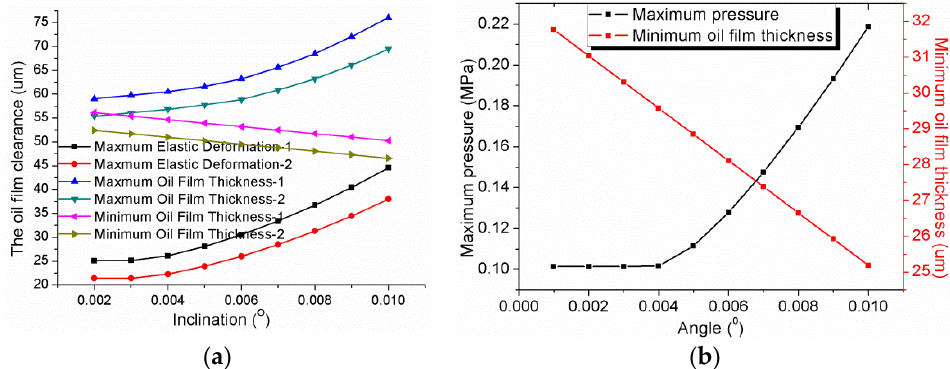
Figure 11. Effect of the inclination on the oil film clearance and pressure. ( a ) The oil film thickness and the elastic deformation with the angle of inclination; ( b ) the minimum oil film thickness and maximum pressure with the angle of inclination.